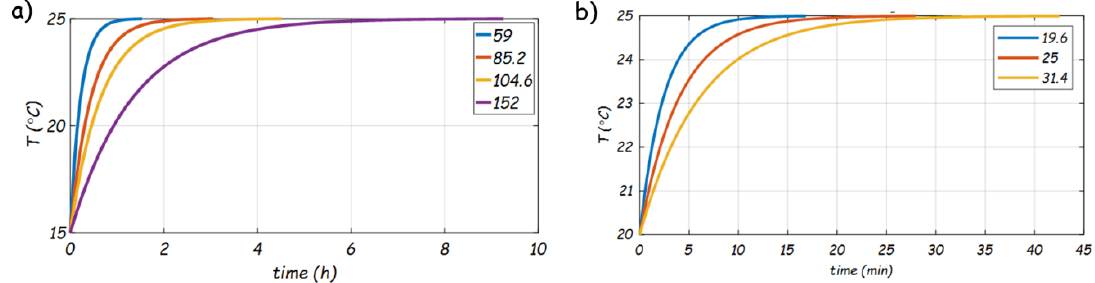
Figure 2. Heating up of the drinking water temperature in ( a ) polyvinyl chloride (PVC) distribution pipes with inside diameters between 59 mm and 152 mm. Original water temperature is 15 °C and soil temperature is 25 °C; ( b ) plastic connection pipes with inside diameters between 19.6 mm and 31.4 mm. Original water temperature is 20 °C and soil temperature is 25 °C.